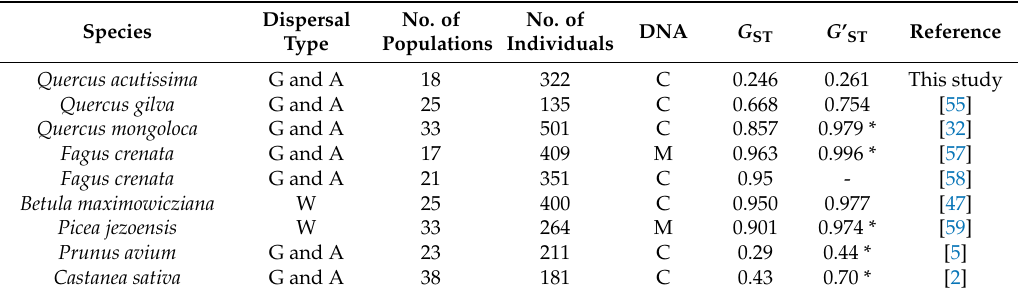
Table 4. Genetic differentiation of organelle DNA of five Japanese tree species, which are little used by humans and two European tree species, which are intensively